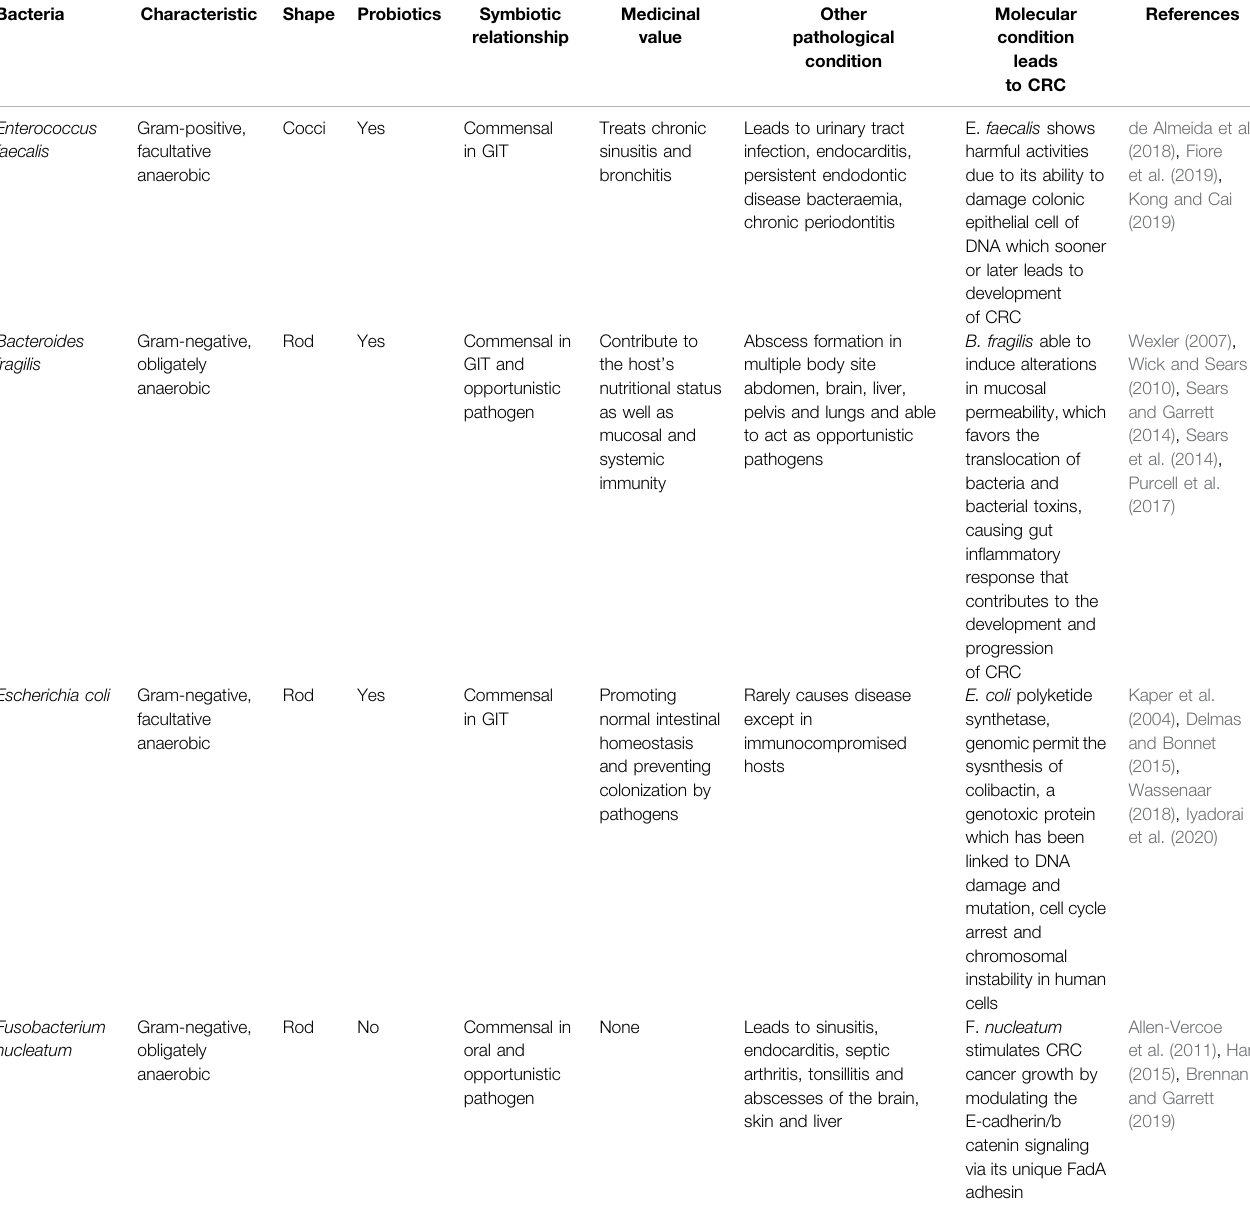
TABLE 1 | Comparison of the gut